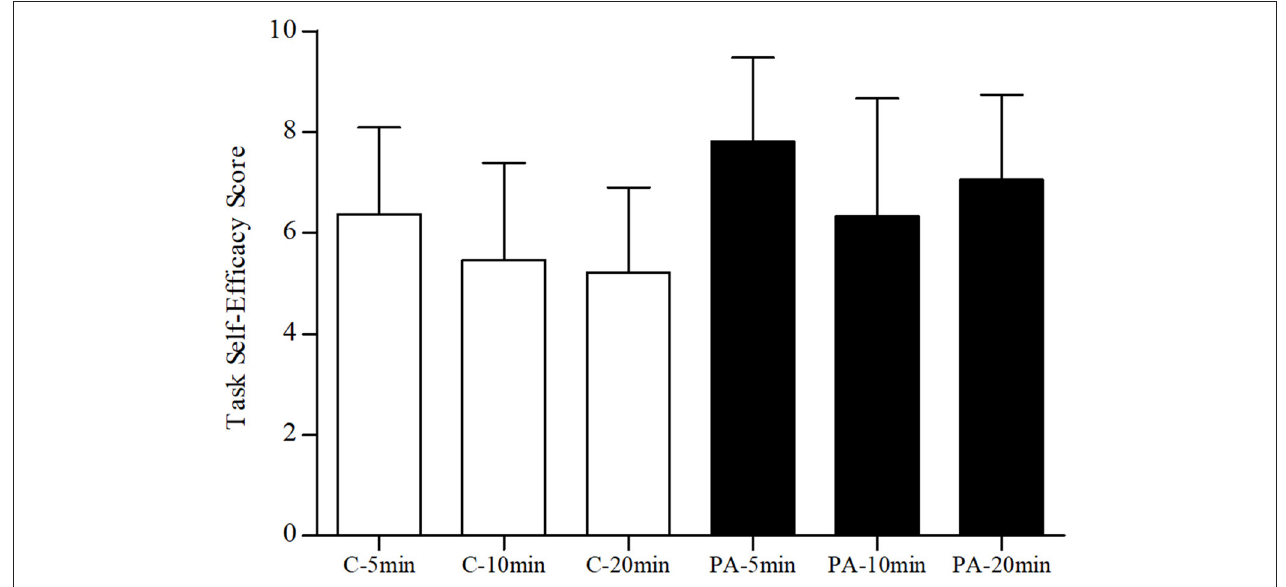
FIGURE 6 | Task self-efficacy scores by condition. C, sedentary control; PA, physical activity break; min, minutes. Error bars represent SD of the